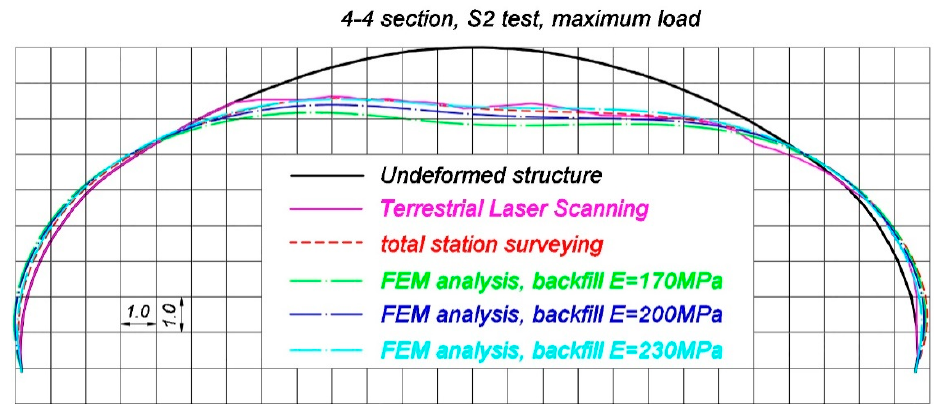
Figure 23. Comparison of the deformed shapes of the bridge in 4-4 section during the S2 test, when maximum load was applied, measured using terrestrial laser scanning, total station, and estimated by means of FEM (deformations in (mm) are 1000 times scaled).